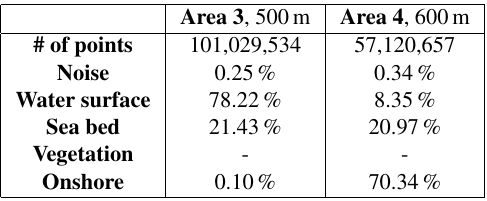
Table 4: Distribution of classes in Area 3 and 4.